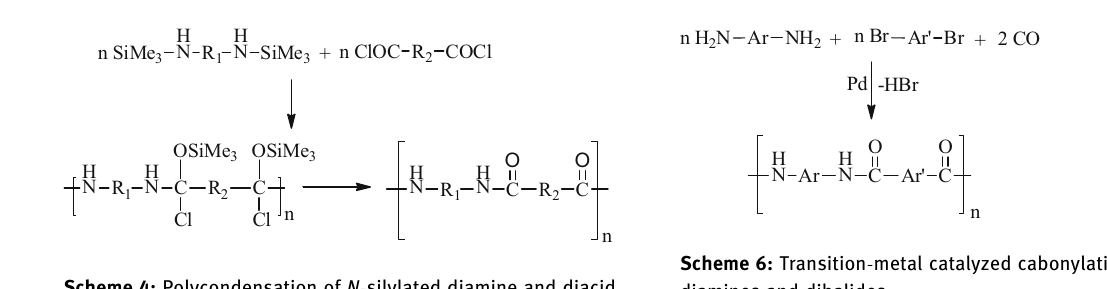
Scheme 4: Polycondensation of N - silylated diamine and diacid chlorides.